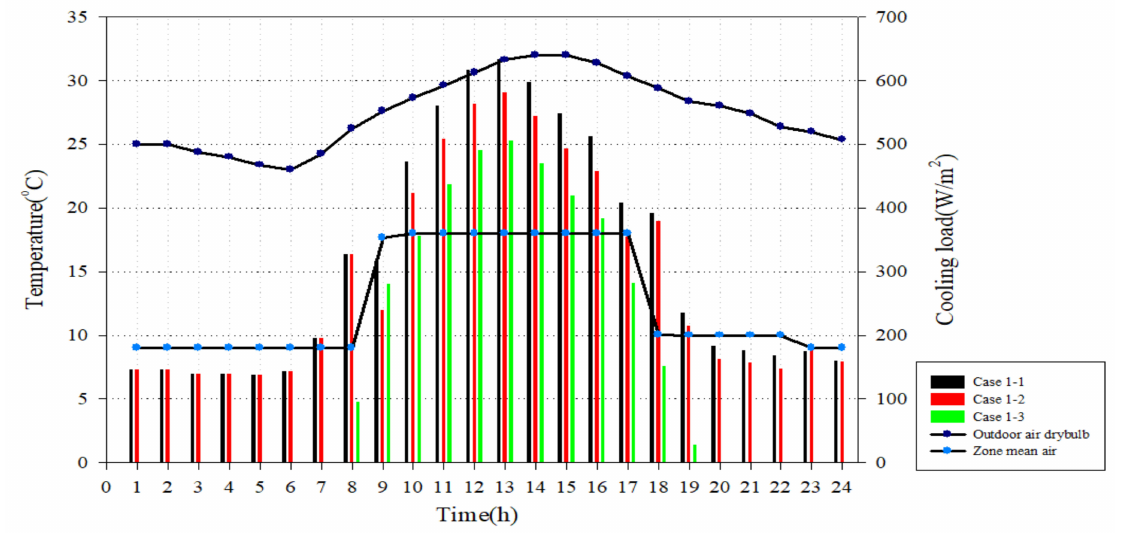
Figure 19. Cooling load changes according to cooling set temperature control (Case 1-1 through